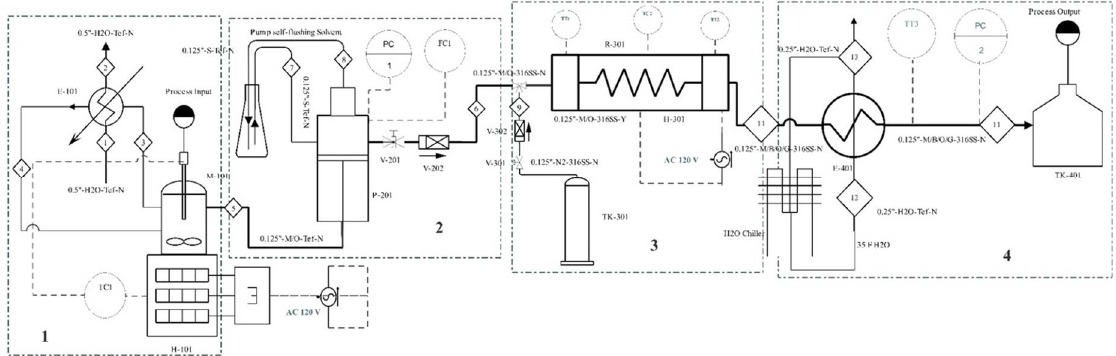
Figure 13. Setup